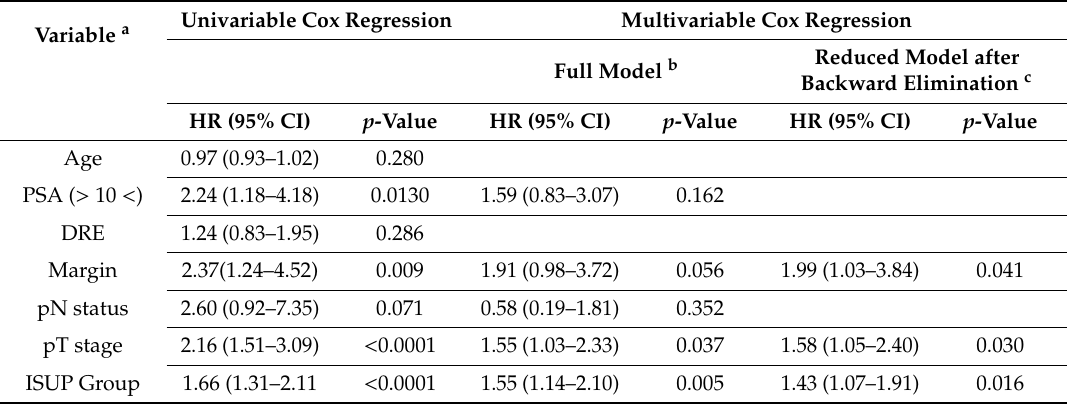
Table 8. Construction of a predictive classifier for biochemical recurrence using Cox regression analyses with clinicopathological variables in 115 patients.